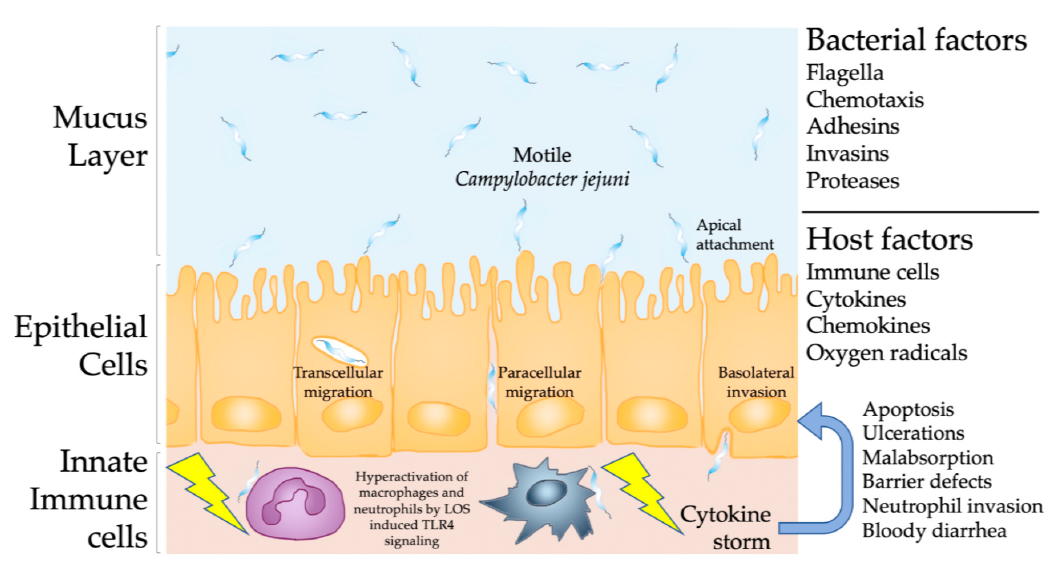
Figure 1. Campylobacter jejuni induced immunopathological responses within the intestinal tract. The highly motile C. jejuni circumvent the mucus layer, cross the intestinal epithelial layer and interact with mucosal and lamina propria cells, resulting in the recruitment of dendritic cells, macrophages, and neutrophils. The interaction of these innate immune cells with the lipooligosaccharide (LOS) of C. jejuni mounts a massive pro-inflammatory cytokine response via TLR-4 signaling, inducing apoptosis and ulcerations in the epithelial layer, progressing into barrier defects, malabsorption and bloody diarrhea.